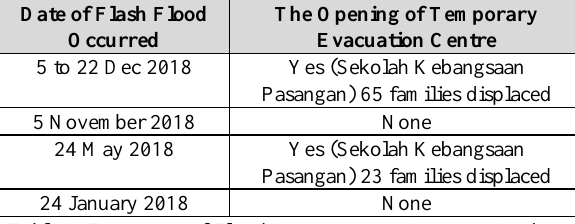
Table 1. Frequency of Flood Occurrence at Kampung Asahan, Kuala Selangor in 2018 (Selangor Disaster Management Unit,